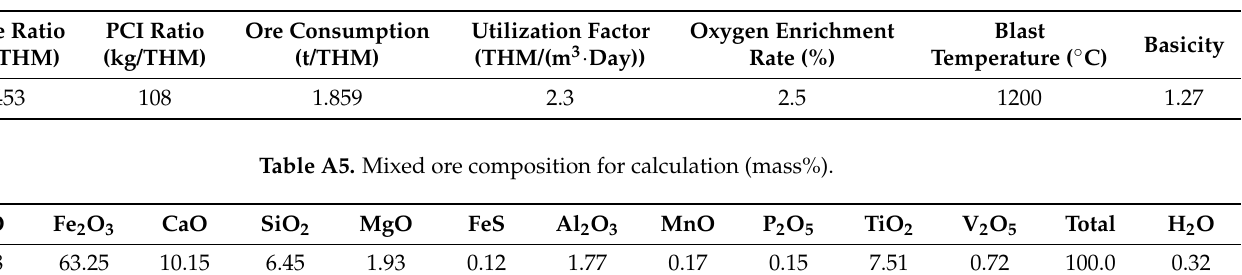
Table A4. Production parameters of blast furnace for calculation.